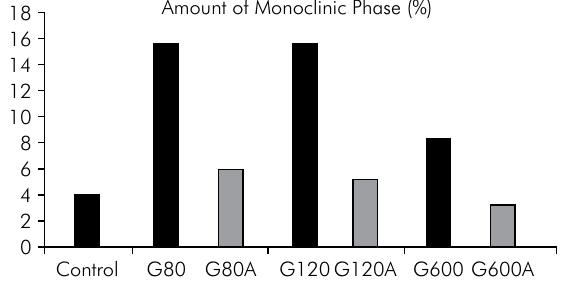
*The same superscript letters in the respective columns indicate statistical similarity ( α <